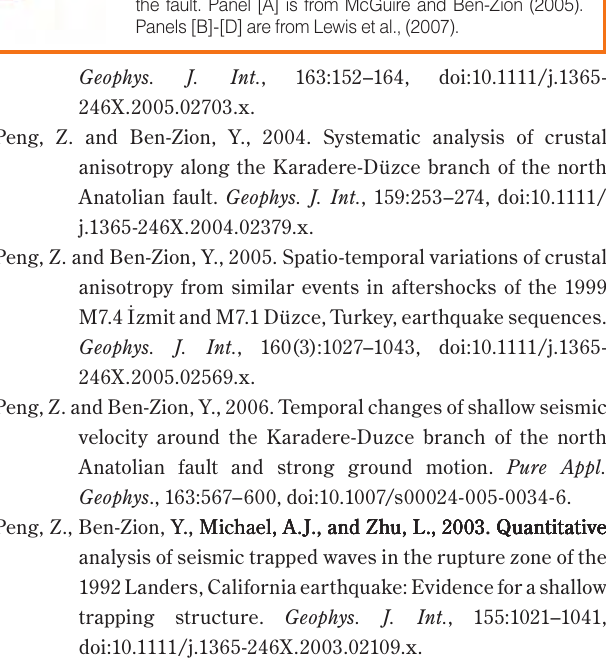
Figure 2. [A] Vertical component P waveforms at Northern California Seismic Network (NCSN) station BHR northeast of the San Andreas Fault (SAF) south of Hollister with direct body wave (vertical line) and first arriving fault zone head wave (diagonal line). [B] Inversion results of P wave veloc- ity contrast across the SAF versus depth from arrival times of head and direct waves. The solid red and blue lines are the best-fitting velocity profiles for the slow and fast sides of the fault, respectively, out of 10 inversion runs. The dashed red and blue lines are the average depth and velocity of each layer, respectively, from the 10 inversions, and the grey shaded areas around the means represent the standard de- viation of the depth and velocity of that layer. The dashed black line is the initial velocity and depth model used in the inversion. The dashed gray line (top horizontal axis) gives the number of events as a function of depth. [C] Example of synthetic waveform fits (red) for observed seismograms (blue) for stations on the fast and slow sides of the SAF. Some of the direct P and head wave arrivals are indicated by arrows with corresponding labels. The average P wave velocities in km s -1 of the crustal block used to generate the synthetic seismograms are given in parentheses under the waveforms. [D] A schematic diagram of the inferred veloc- ity structure of the SAF south of Hollister, consisting of two layered quarter-spaces, joined along a sharp material inter- face, and a shallow asymmetric low velocity zone around the fault. Panel [A] is from McGuire and Ben-Zion (2005). Panels [B]-[D] are from Lewis et al.,